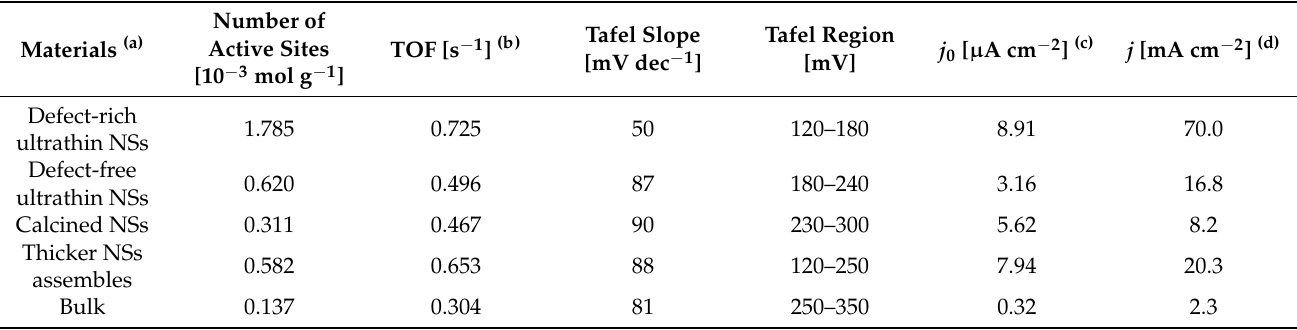
Table 2. HER parameters (number of active sites (10 − 3 mol g − 1 ), turnover frequency (TOF) (s − 1 ), Tafel slope (mV dec − 1 ),